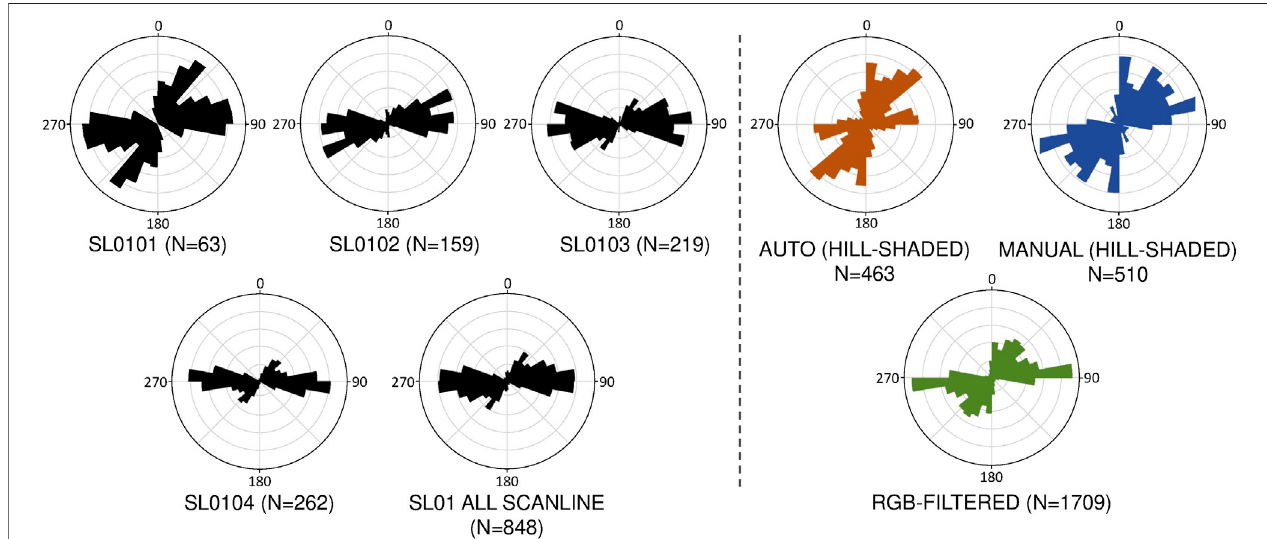
FIGURE 6 | Three lineament trends are distinguished from all methods on SL01 outcrop. The results of the scanline (black graphs), automated hill-shade (orange graphs), manual hill-shaded (blue graphs), and RGB- fi ltered DSM (green graphs) methods are portrayed on rose diagrams.